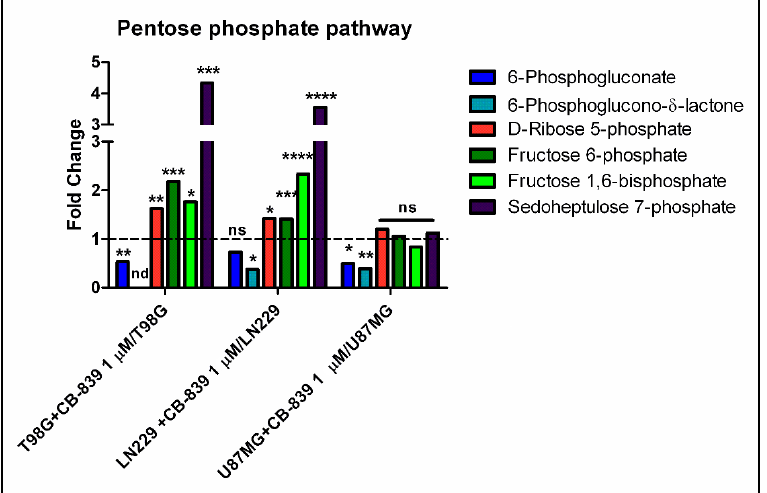
Figure 9. CB-839 altered the abundance of some pentose phosphate pathway-related metabolites. 6-Phosphogluconate was lower in treated T98G and U87MG cells, and 6- phosphoglucono- δ -lactone was diminished in LN229 and U87MG, while it was not detected in T98G. D-ribose 5-phosphate, fructose 6-phosphate, fructose 1,6-bisphosphate, and sedoheptulose 7-phosphate significantly accumulated in CB-839 treated T98G and LN229 cell lines. The samples were run in triplicate. For more details, see Section 2. ns — non-significant. nd — non-detected. * p < 0.05, ** p < 0.01, *** p < 0.001, **** p < 0.0001.